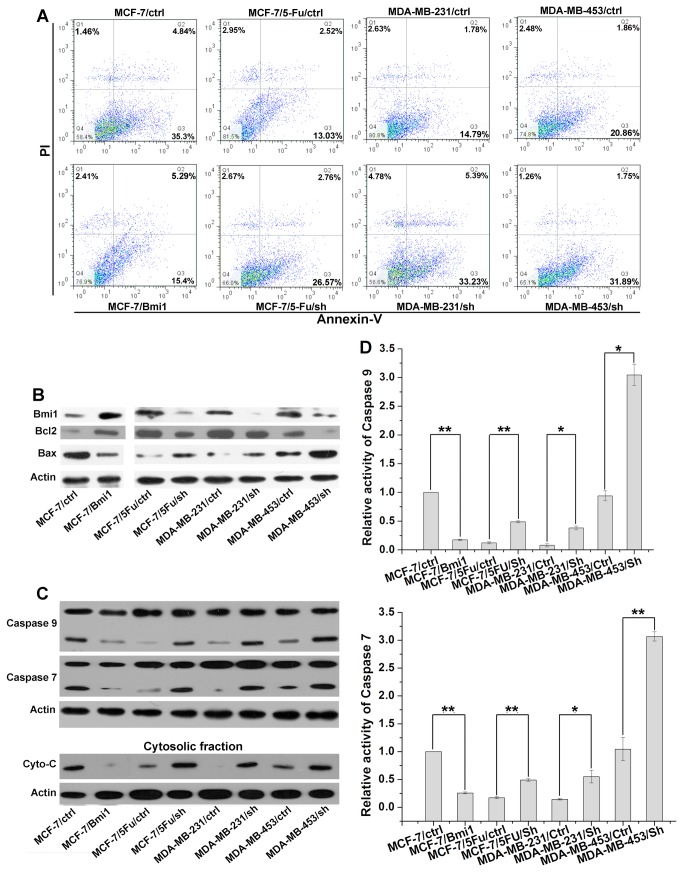
Bmi1 affects the mitochondrial apoptotic pathway in breast cancer cells.(A) Effects of 100mg/L on selected cell lines with different Bmi1 expression level. After exposure to 100mg/L 5-Fu for 12h, cells were harvested and cell death were measured with Apoptosis Detection Kit and each figures represents three independent experiments; (B) Western blot showed the reverse relationship between Bmi1 and apoptosis related molecules Bcl2 and Bax in selected cell lines; (C) Western blot showed cytochrome-C (Cyto-C) release and Caspase 9 and Caspase 7 activation after 100mg/L 5-Fu treatment on selected cell lines; (D) Effect of Bmi1 on 5-Fu-induced caspase 9 and caspase 7 activation on selected cell lines. The relative activation of caspase 9 and caspase 7 was calculated from the average of three experiments, versus control, * p<0.05, ** p<0.01.